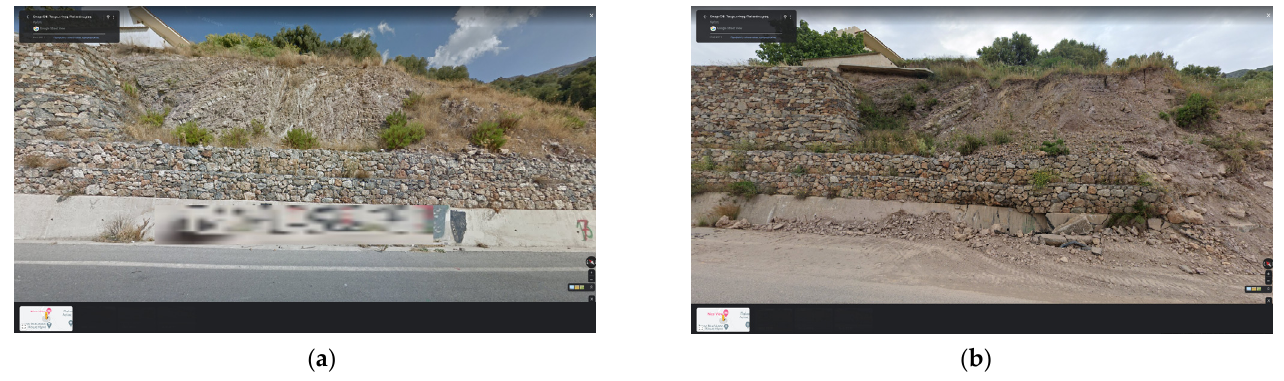
Figure 6. Enriching the landslide inventory about the activity status of an existing landslide in the road connecting Tavronitis village with Palaiochora city using Google Street view: ( a ) Image obtained in 2014 [37]; ( b ) Image obtained in 2019 [38].